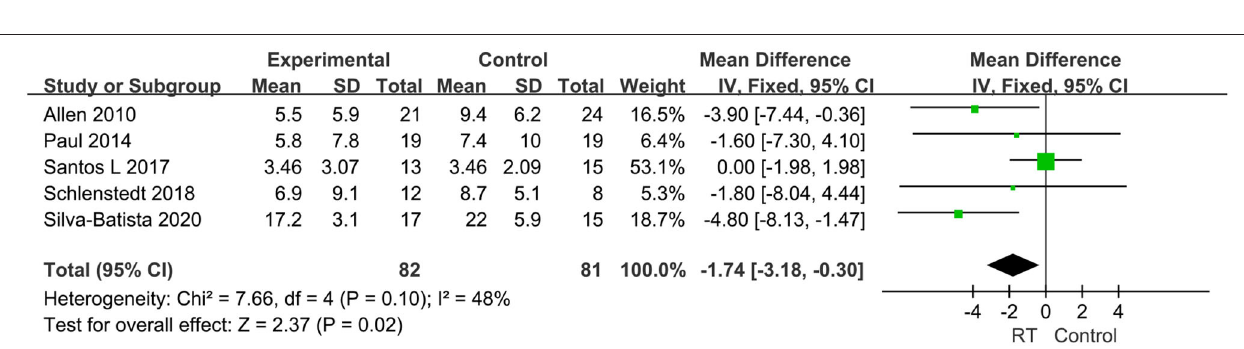
FIGURE 8 | Forest plots of the effects of lower limb RT on gait performance—freezing of gait in PD. CI, confidence interval.